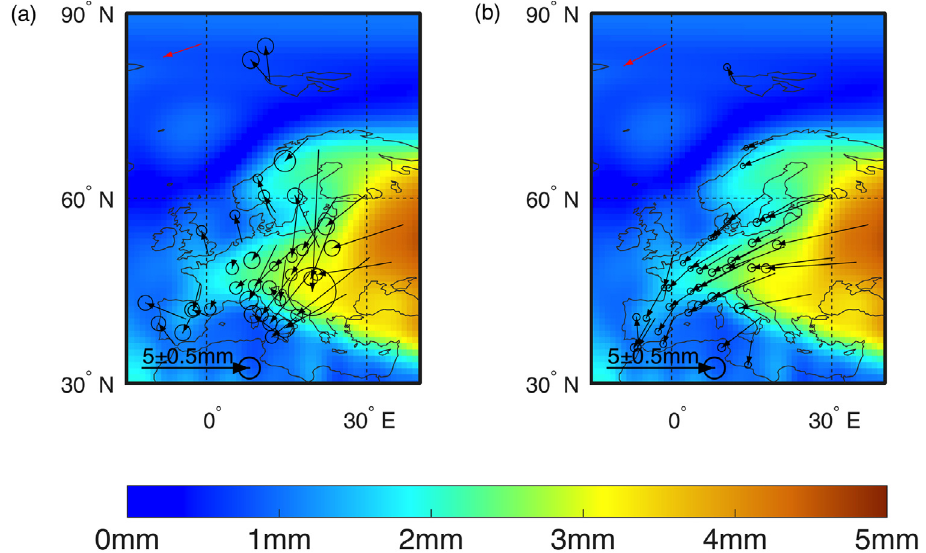
Figure 4. Annual amplitudes and phases of GPS height residuals (left) and GRACE-derived vertical displacements (right). The annual phase is defined as { in sin[2 r ( t − t )+ { ], where t refers to the start of the year (e.g., 2002.0). The length of the arrow represents the annual am- 0 0 plitude of the site, and the direction of the arrow is the peak-value month counted counterclockwise from the east (January to December). The red arrow on the upper left represents the average annual amplitudes and phases of the 36 selected sites in Europe. The scale of the arrow is marked on the lower left. Background color maps show gridded estimates of annual amplitudes of vertical displacements predicted from GRACE GSM products. A 300 km Gaussian smoothing has been applied to the GRACE data.